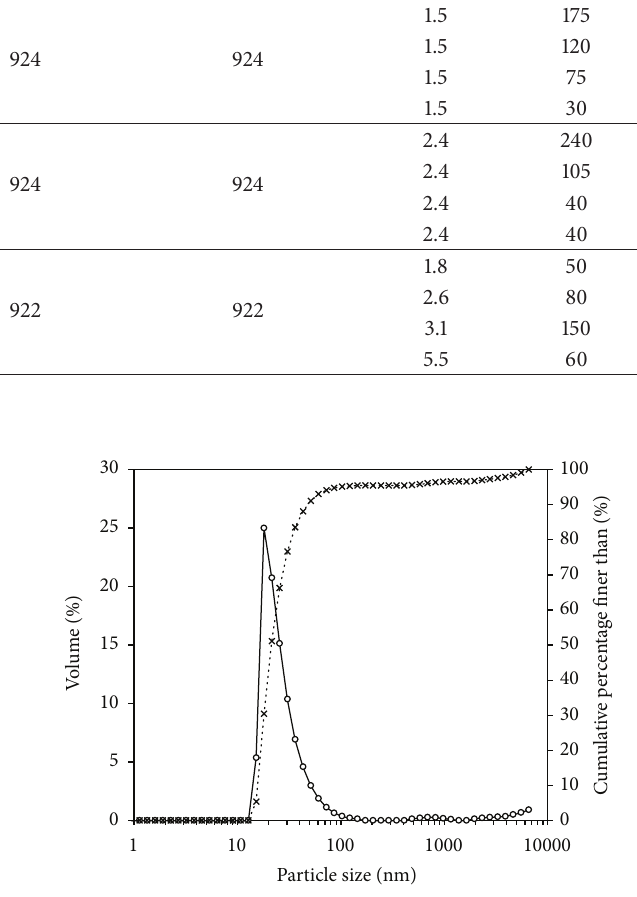
Figure 3: Particle size distribution of NS suspension by dynamic light scattering